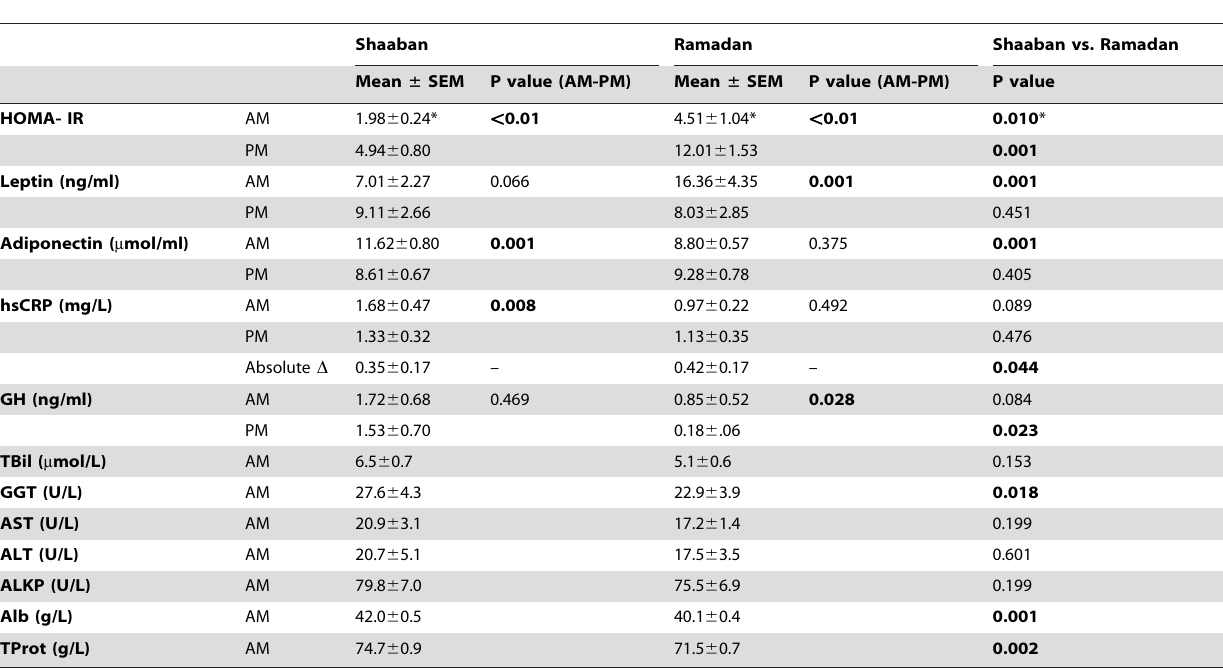
Table 1. HOMA-IR, and concentrations of adipokines, GH and other metabolic/inflammatory parameters during Shaaban and